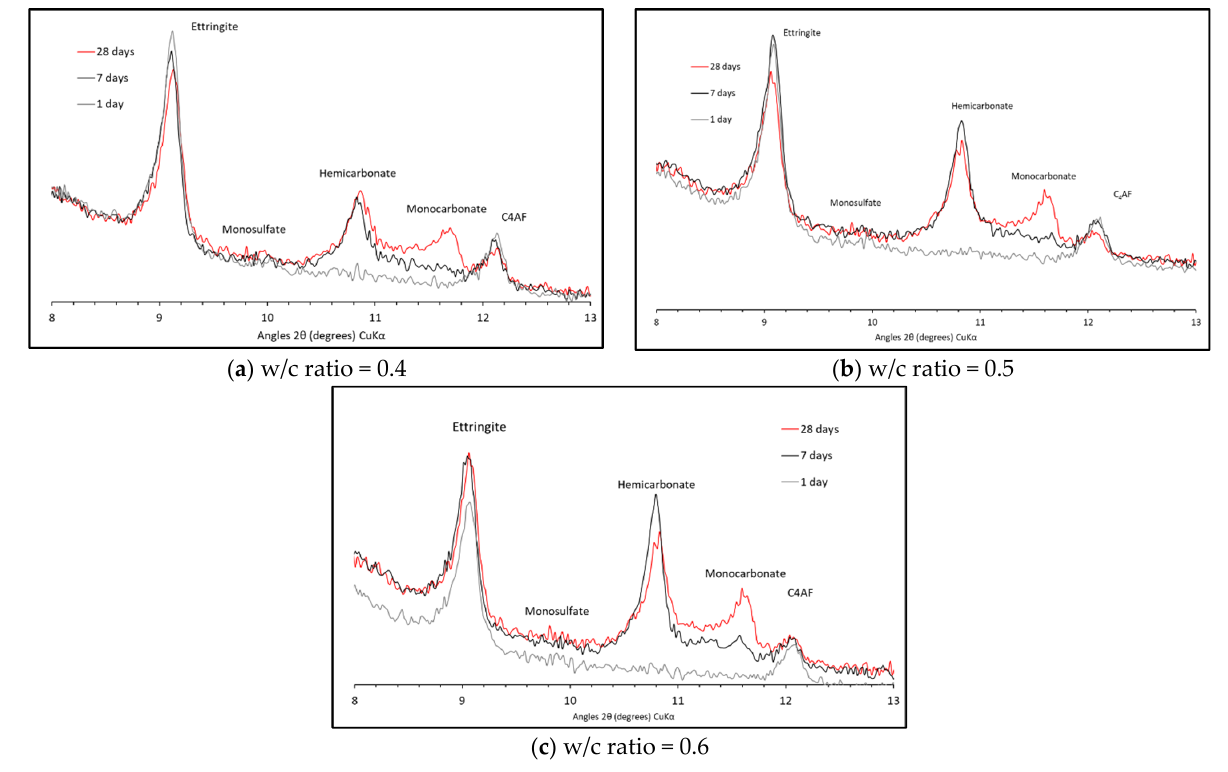
Figure 2. XRD pa tt erns from 8 − 13 angle 2 θ .